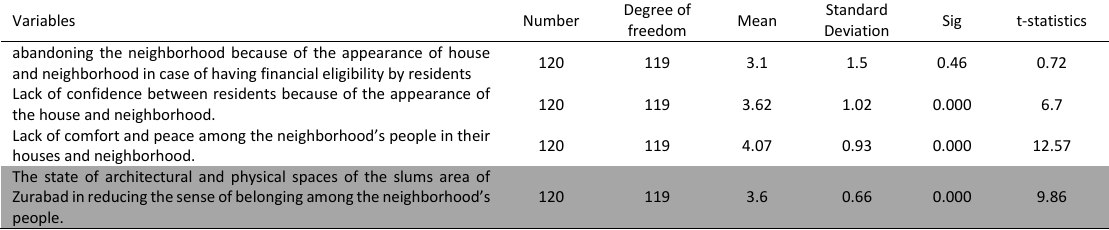
Table 6: Test results for the current state of the architectural and physical spaces of the slums area of Zurabad of Karaj in reducing the sense of belonging of its people Variables